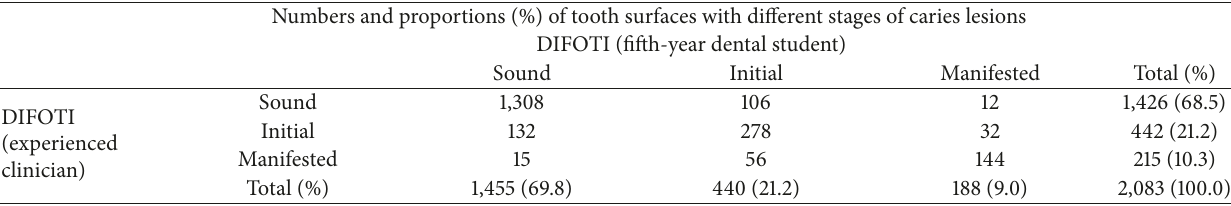
Table 3: Findings of fiber-optic transillumination (DIFOTI) images by a fifth-year dental student and an experienced clinician; numbers and proportions of tooth